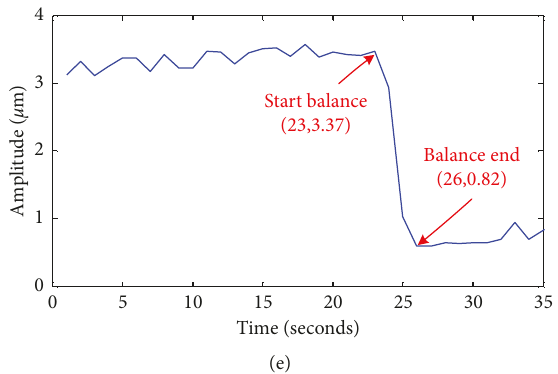
Figure 20: Comparison of balance information in the X - Y direction at 15,000rpm. (a) X -time domain. (b) Y -time domain. (c) X -frequency domain. (d) Y -frequency domain. (e) Online balance